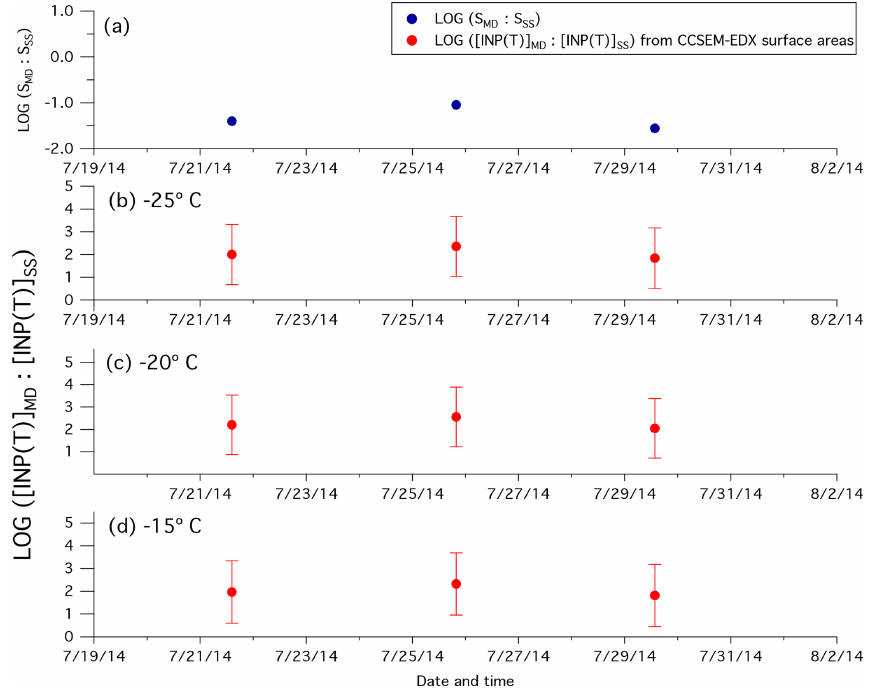
Figure 4. (a) Ratios of the surface area of mineral dust particles to the surface area of sea salt particles measured by CCSEM-EDX (blue cir- cles). Ratios of predicted [INP( T )] MD to the predicted [INP( T )] SS calculated using CCSEM-EDX measurements (red circles) at (b) − 25 ◦ C, (c) − 20 ◦ C, and (d) − 15 ◦